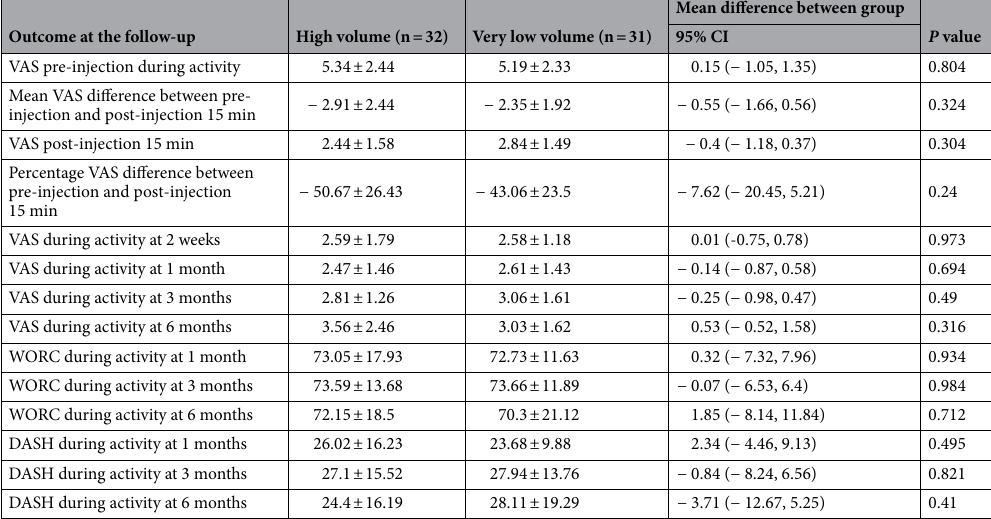
Table 3. Result of VAS during activity outcomes at pre injection, post injection 15 min, Percentage difference improvement after 15 min, 2 weeks and 1, 3 and 6 months, WORC at 1 month and DASH at 1, 3 and 6 months between high volume and very low volume corticosteroid injection.